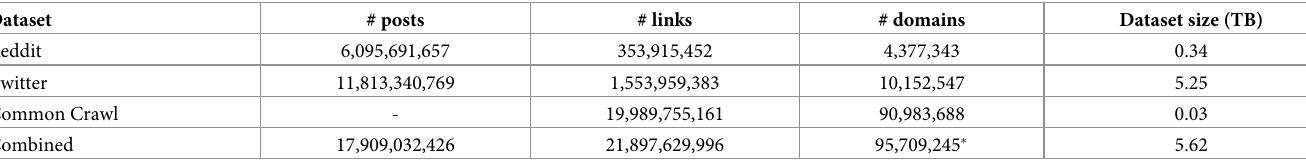
Table 1. Summary of the dimensionality of our datasets: The number of posts, links contained in posts, and unique domains linked in each of the two datasets. For reference only, we also show the size of the dataset in occupied disk space (both datasets are compressed with the BZIP2 utility). The combined number of domains (indi- cated by � ) is the number of unique domains in our